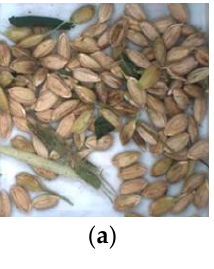
Figure 16. Impurity identification based on color space and morphology. ( a ) Original image; ( b ) image equalization; ( c ) threshold segmentation; ( d ) removing interference; ( e ) identification result.